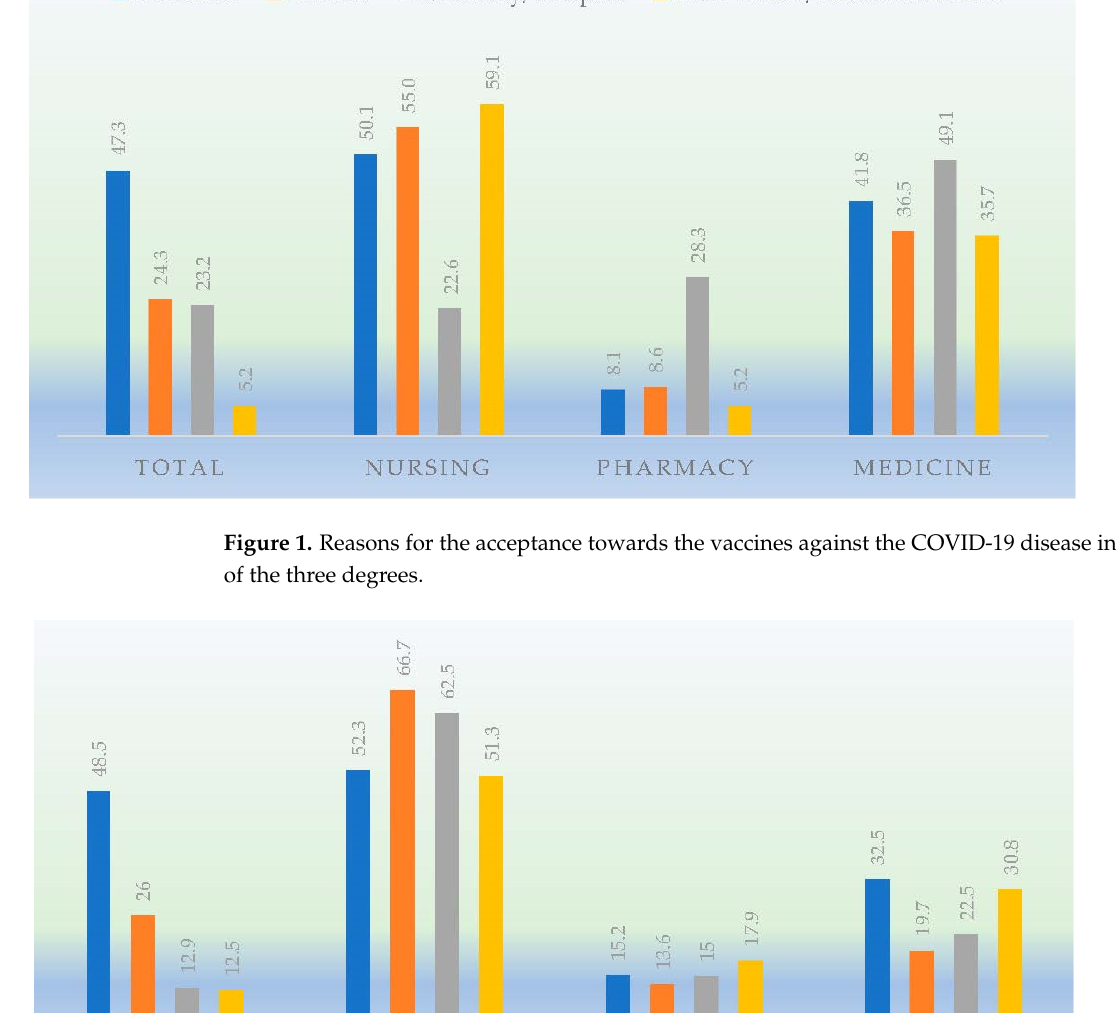
Figure 2. Reasons for the rejection towards the vaccines against the COVID-19 disease in students of the three degrees. the three